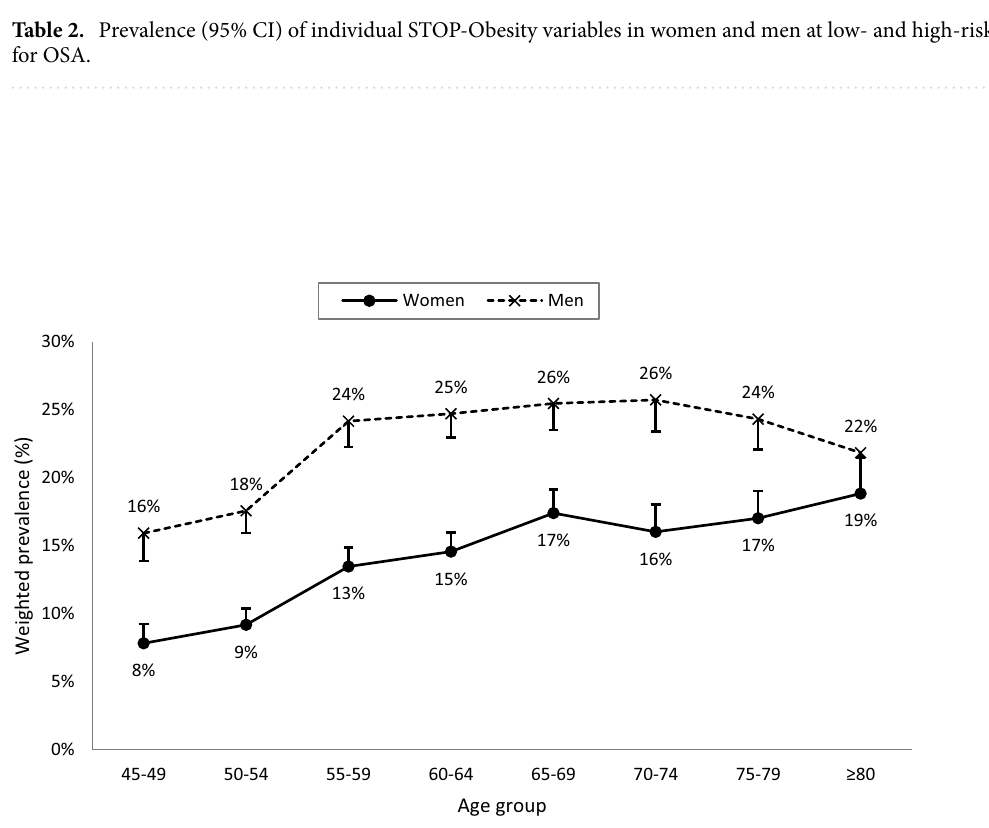
Figure 2. Prevalence of participants at high-risk for OSA by age group in women (solid curve) and men (dashed curve). Error bars represent the 95% confidence